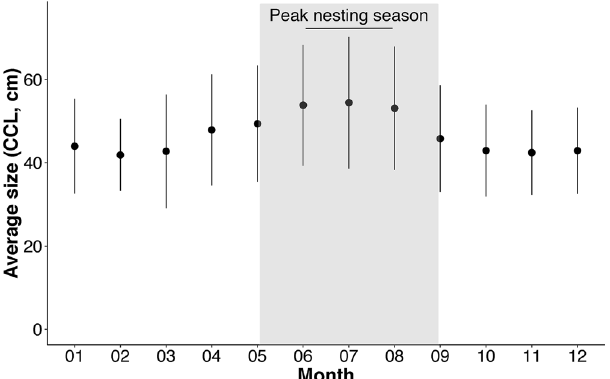
Figure 1. Average (± standard deviation) size (curved carapace length, CCL) per month calculated from loggerhead turtles measured between 1990 and 2020 (n = 700) in the French Mediterranean Sea. The shaded area represents the nesting season for Mediterranean loggerheads (late May to early September with a peak in nesting activity from June to early August 34,35 ).